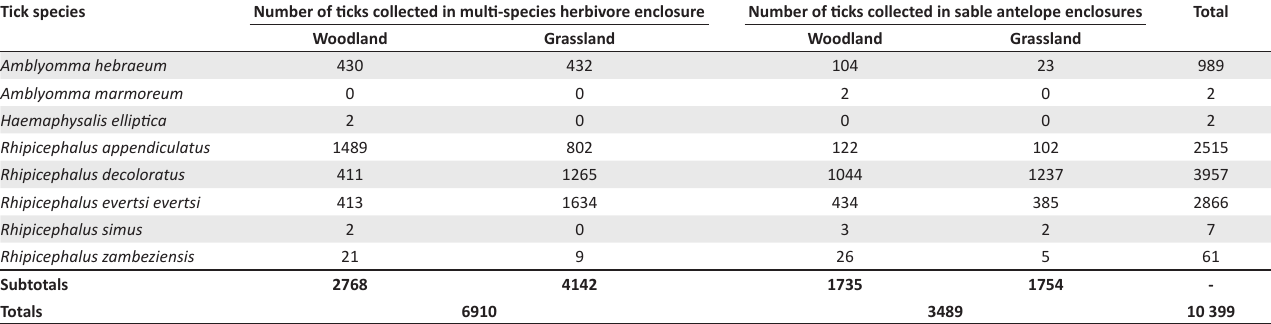
TABLE 1: Total number of ticks collected from the woodland and grassland habitats in the multi-species herbivore enclosure and sable antelope breeding enclosures on the farm Hoopdal KQ96 between July 2011 and July 2013. Tick